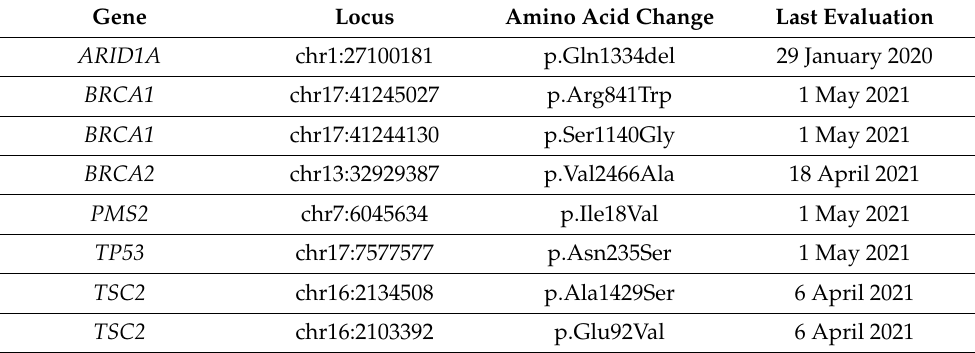
Table 2. A list of encountered benign, likely-benign germline variants annotated from Varsome using ClinVar verdicts 1